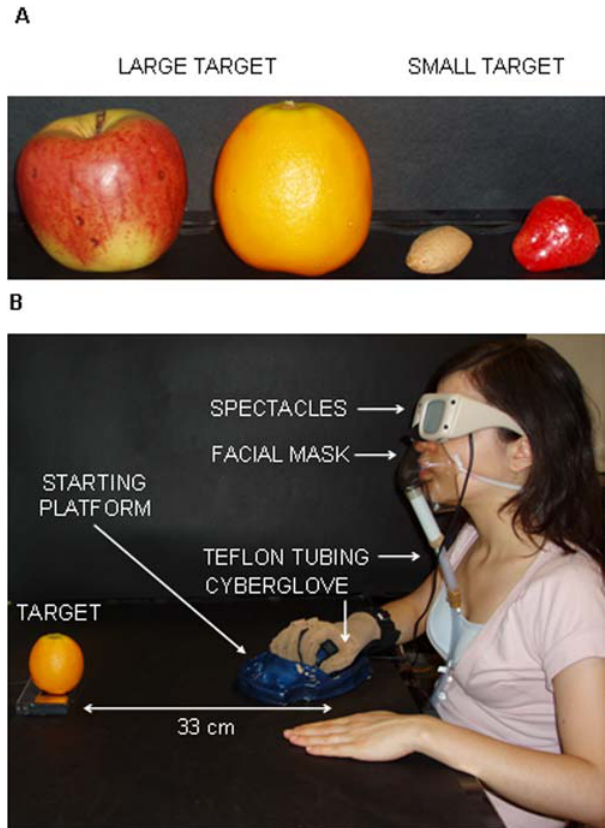
Figure 1. The visual targets and the experimental set up. (A) The visual targets defined as ‘large’ were an apple and an orange, whereas those defined as ‘small’ were an almond and a strawberry. (B) Legends indicate the parts composing the experimental set